Question: Sum up the contents of this chart in one sentence.
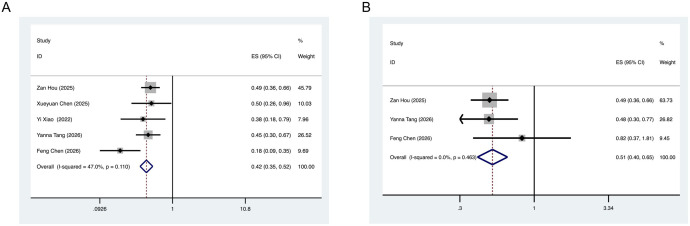
Answer: Updated meta-analysis: forest plot of hazard ratios for PFS (A) and OS (B) in patients with PLELC receiving first-line chemo-immunotherapy versus chemotherapy alone. PLELC, pulmonary lymphoepithelioma-like carcinoma;PFS, Progression-Free Survival;OS, overall survival.